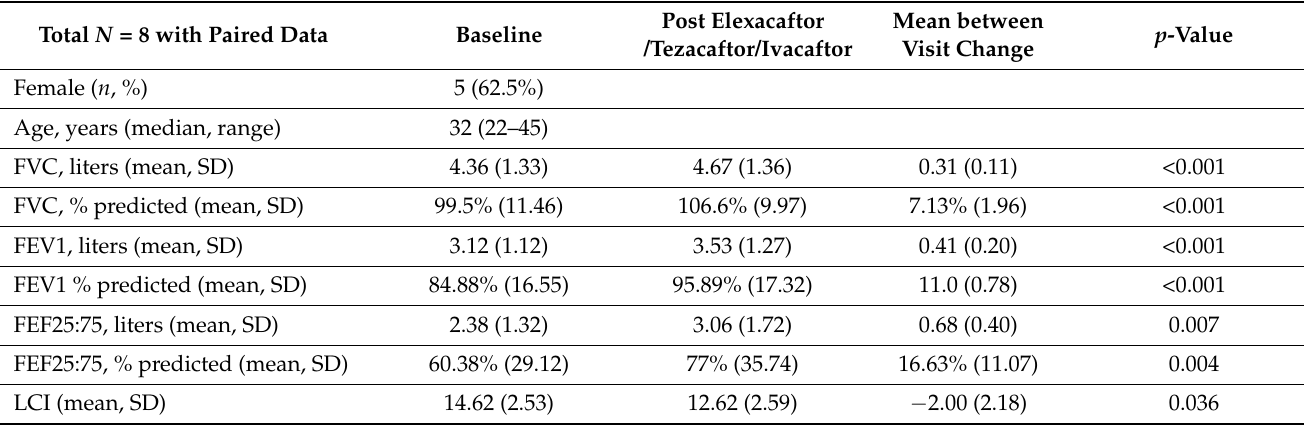
Table 1. Demographic and lung function data.